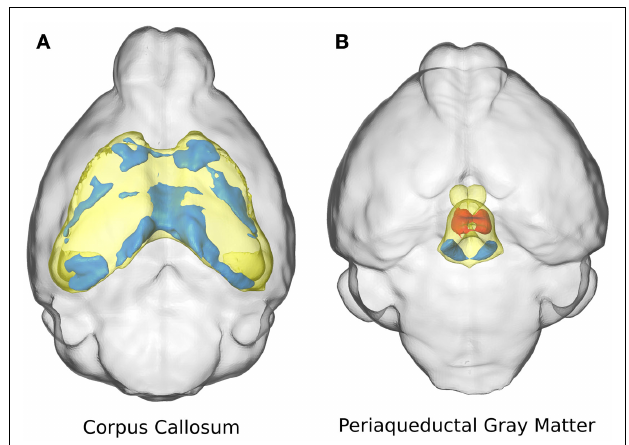
FIGURE 3 |The relative volume differences in the corpus callosum (A) and the periaqueductal gray matter (B) are highlighted. The specified anatomical regions are displayed in yellow. Significant relative volume increases are displayed in red while significant volume decreases are displayed in